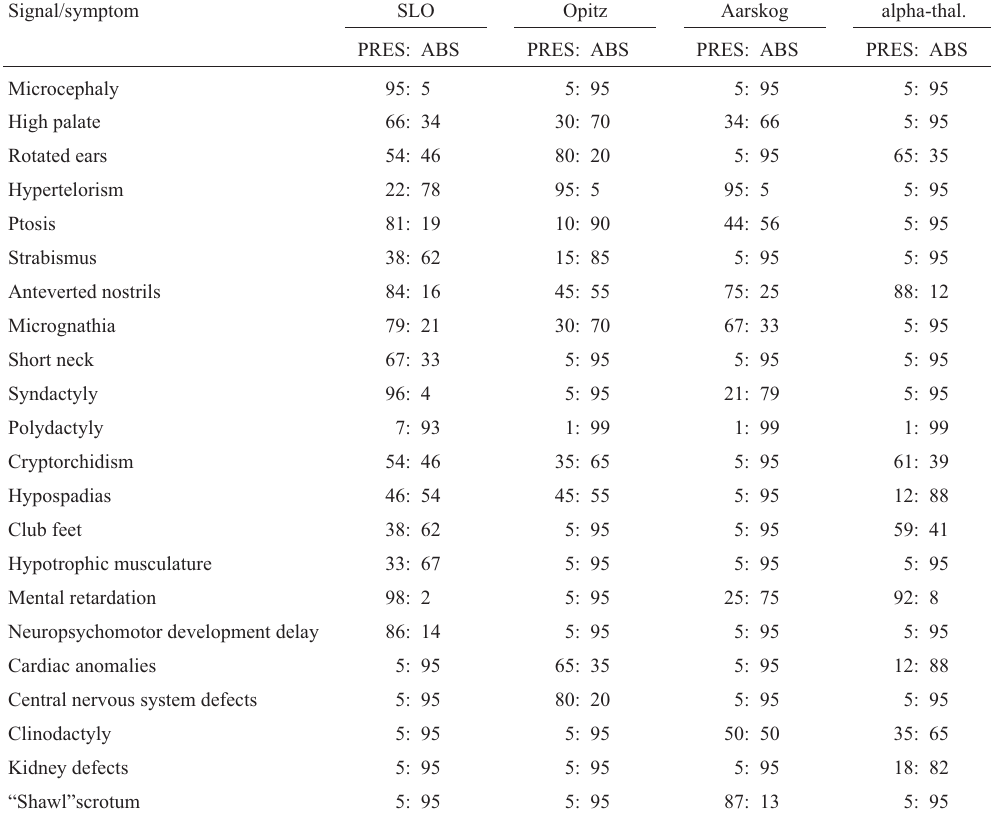
Table 2 - Reported frequencies of signs and symptoms in SLOS, Opitz syndrome, Aarskog syndrome and alpha-thalassemia/mental retardation syndrome. Whenever the frequency of a given feature (with the exception of polydactyly) was not increased in a given syndrome, a frequency of 5% was assigned to